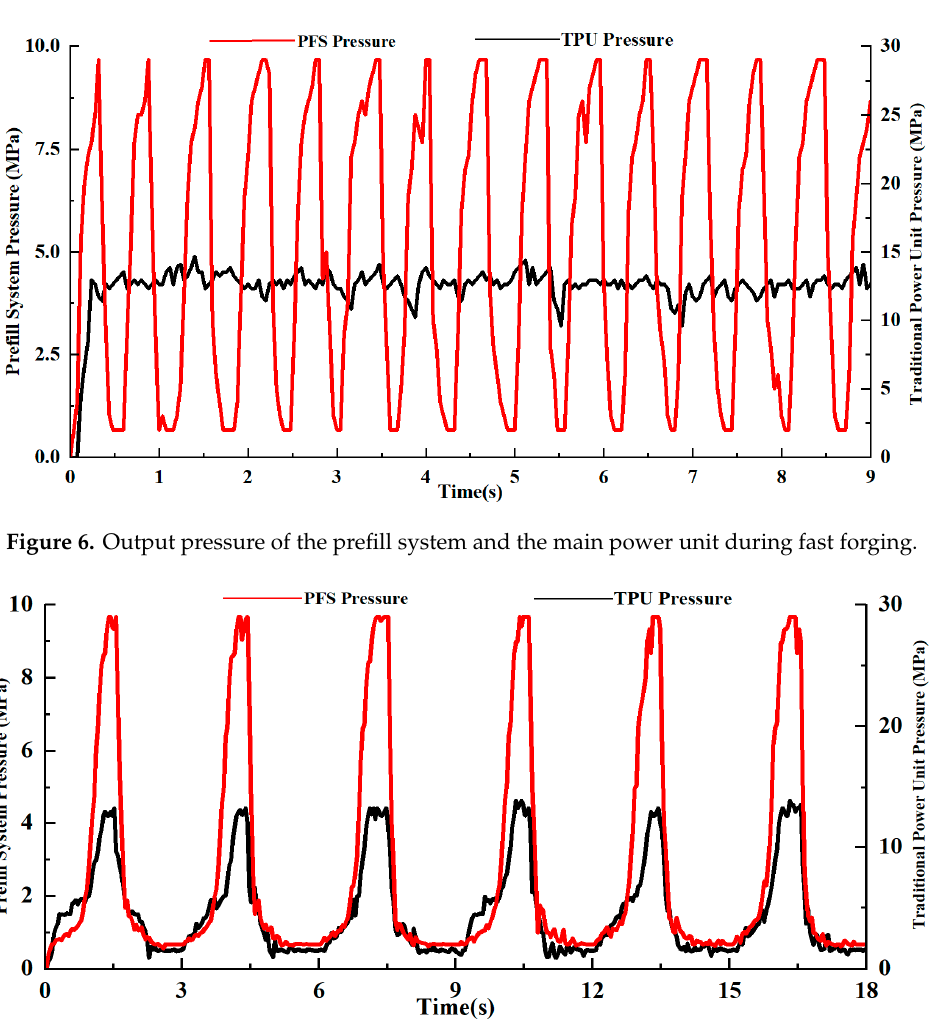
Figure 8. Unloading pressure of the hydraulic press with the energy ‐ saving system and the traditional hydraulic press during fast forging.